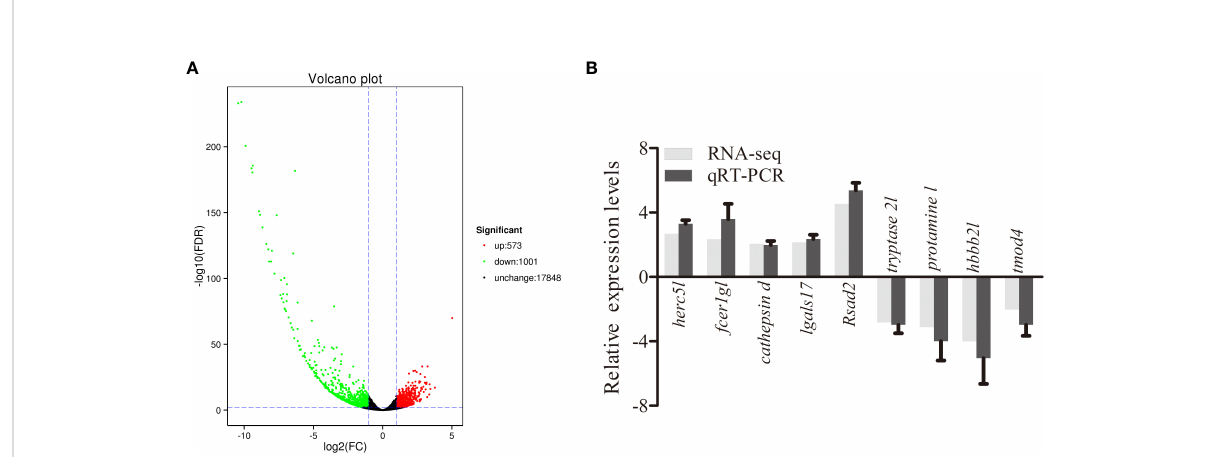
FIGURE 1 Analysis and validation of DEGs. (A) The “ volcano plot ” picture of DEGs following MSRV infection. Red spot, up-regulated; green spot, down- regulated; black spot, no difference in expression. (B) Validation of RNA-seq data by qRT-PCR analysis. X-axis, gene name; Y-axis, fold change in gene expression. The relative expression of 10 DEGs were determined by qRT-PCR and compared with the results of